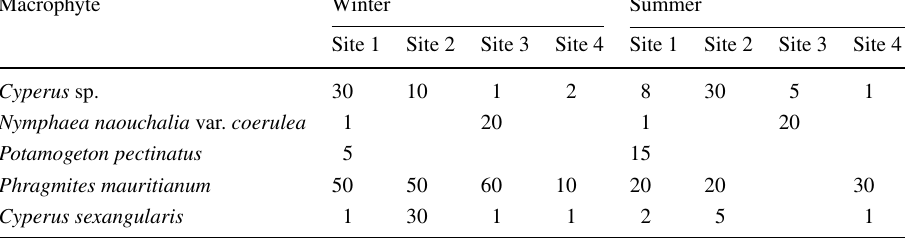
observed (% cover) from Sambandou